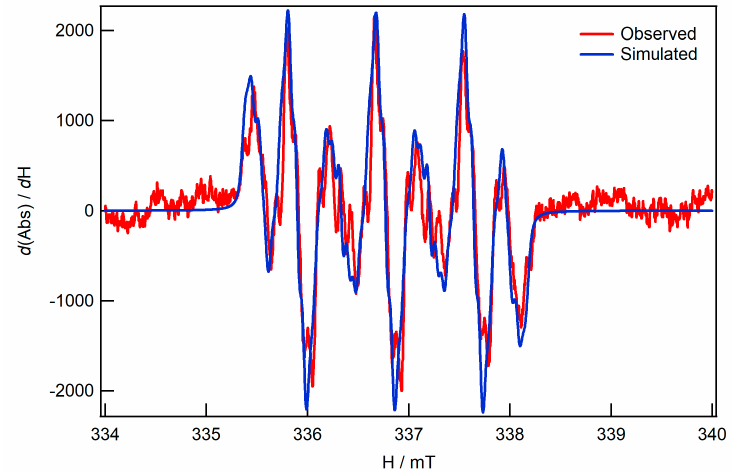
Figure 3. X-band EPR spectra of in-situ reduced I-bzNO 2 and simulated spectrum. The simulated spectrum was calculated using the EasySpin suite of routines [24]. Details of the simulation parameters are given in Table S1.